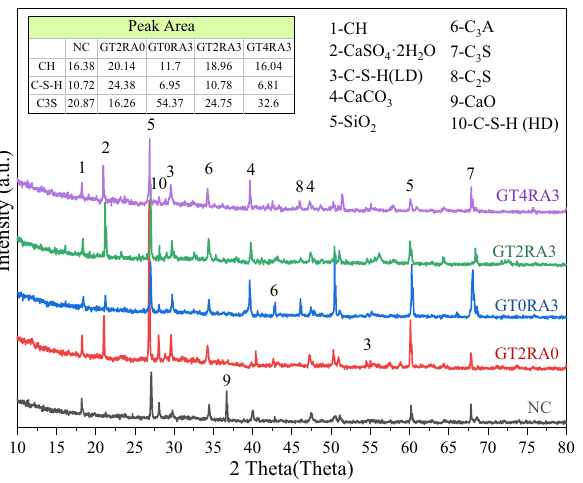
Figure 15: Hydration product analysis of GTRAC.